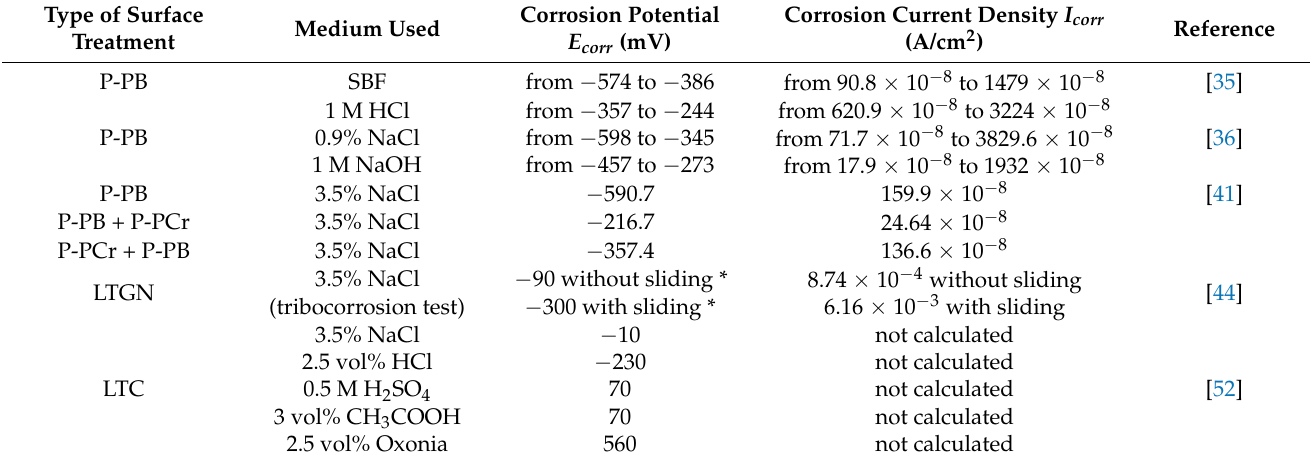
Table 11. Corrosion potential E corr and corrosion current density I corr of surface layers, produced in 316L austenitic steel using thermochemical